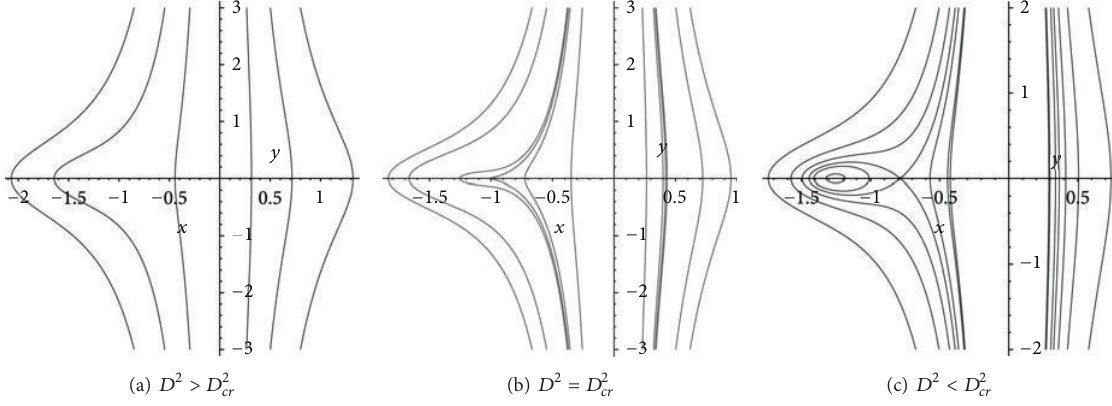
Figure 8: The phase portraits of system (6) for 𝑛 = 2𝑚 + 1 , 𝛽 > 0 , 𝐺 1 < 0 , and 𝜎 > 0 .